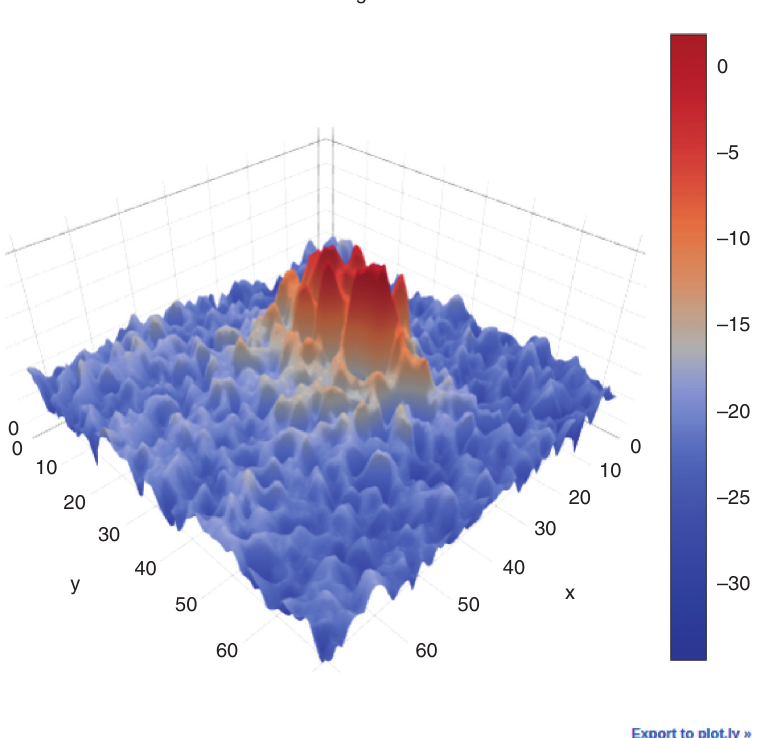
Figure 2: 3D Plot of a